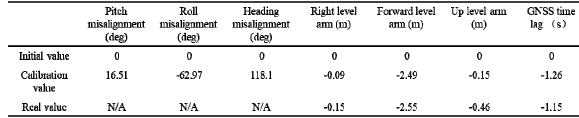
Table 1. the calibration results in the tunnel experiment